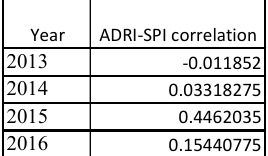
Table 5: Annual ADRI and SPI correlation for years with complete